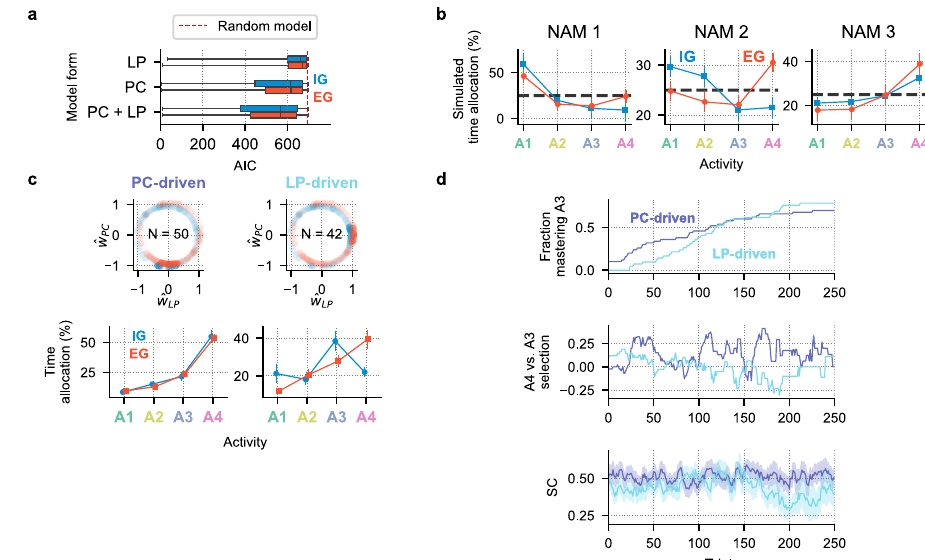
Fig. 5 Computational modeling results. a The bivariate models had better AIC scores both across and within groups ( N EG = 188; N IG = 177), compared to random-choice and univariate baselines univariate models. Box boundaries represent the 1st and the 3rd quartiles, and the lines inside show median scores; whiskers represent the full sample range. The dotted red line shows the AIC of the random-choice model. b Fitted coef fi cients reproduce choice patterns across instruction and NAM groups. The panels show the average time allocation patterns obtained by simulating activity choices over 250 trials using N = 500 randomly sampled coef fi cients from the pool of all fi tted bivariate models. c Models of two distinct activity-selection strategies. The top row shows the joint distributions of normalized bivariate-utility coef fi cients. Subsets of these distributions whose data is presented below are highlighted with solid colors. These subsets were formed by fi rst grouping all fi tted models into three segments along ^ w PC and ^ w LP, and then selecting groups corresponding to PC-driven and LP-driven pro fi les. Sample sizes of each subset are shown their respective subpanels. The bottom row shows mean relative frequencies of selecting each activity in the corresponding subset of participants depicted immediately above. LP-driven participants sampled the unlearnable activity (A4) in relative moderation compared the PC-driven group. d LP-driven participants selected allocated time more ef fi ciently for learning and had better learning outcomes. The top row shows fractions of participants in the two groups that reached an objective criterion of 13/15 trials on the hardest learnable activity (A3) at least once in the experiment. The middle row shows the relative preference for activity A4 over A3, de fi ned as the difference between fractions of participants (that still have not mastered A3) who selected A4 minus the fraction selecting A3. The bottom row shows average SC scores in the two groups (shaded regions indicate the standard error). Source data are provided as a Source Data fi